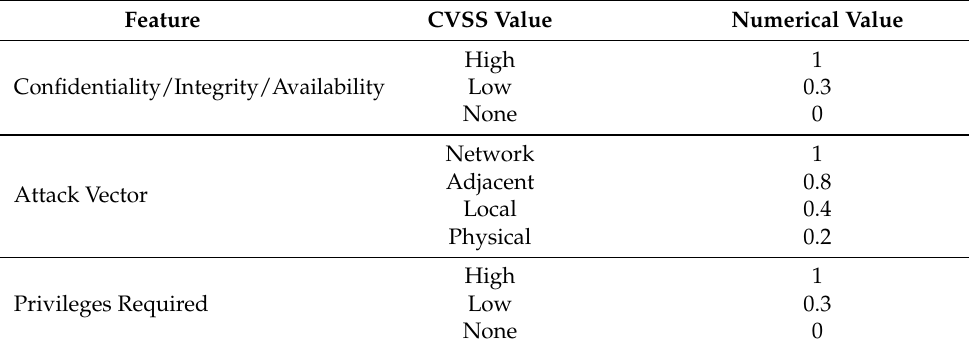
Table 2. Example of CVSS value translation